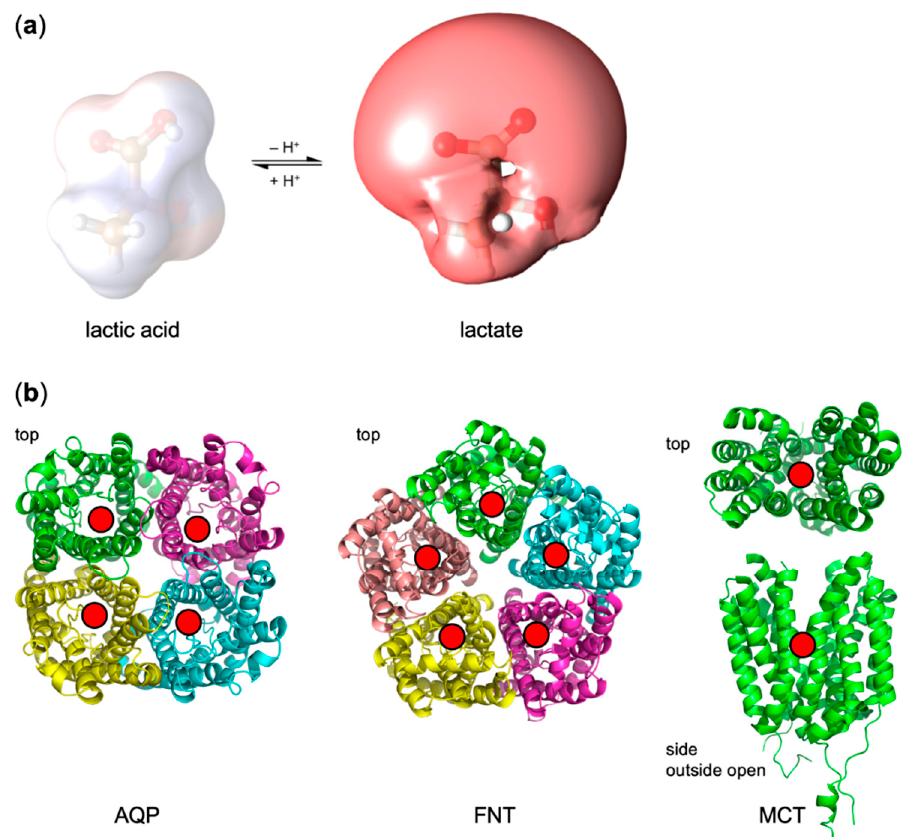
Figure 1. ( a ) Lactic acid / lactate protonation equilibrium. Shown are the molecule structures and electrostatic potential maps (blue / red scale: ± 4 kT e – ). ( b ) Structures of membrane proteins facilitating transmembrane lactate transport. Aquaporin homotetramers (AQP; PDB# 1FX8) harbor one substrate (red circle) channel in each protomer. Formate–nitrite transporters (FNT; PDB# 3KCU) exhibit a structure mimicry with the AQPs on the protomer level, yet function like proton-driven transporters. Alternating access monocarboxylate transporters (MCT; PDB# 6HCL) bind the substrate and a proton on one side and undergo a conformational change for release at the trans-side of the membrane.